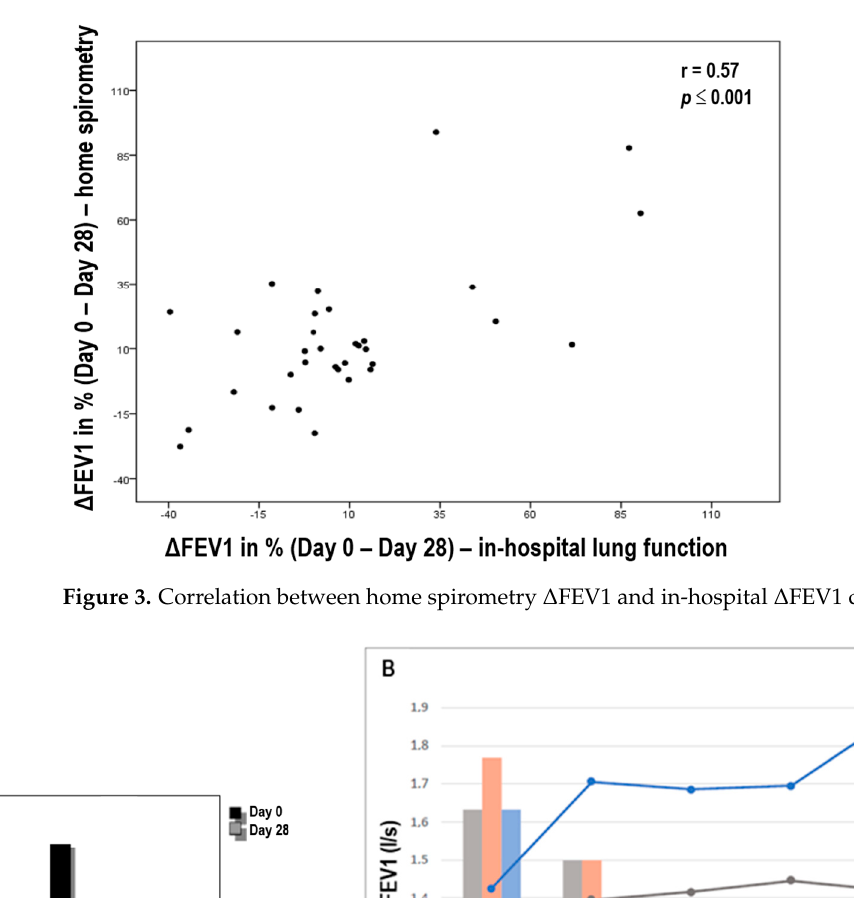
Figure 3. Correlation between home spirometry Δ FEV1 and in-hospital Δ FEV1 days 0–28.